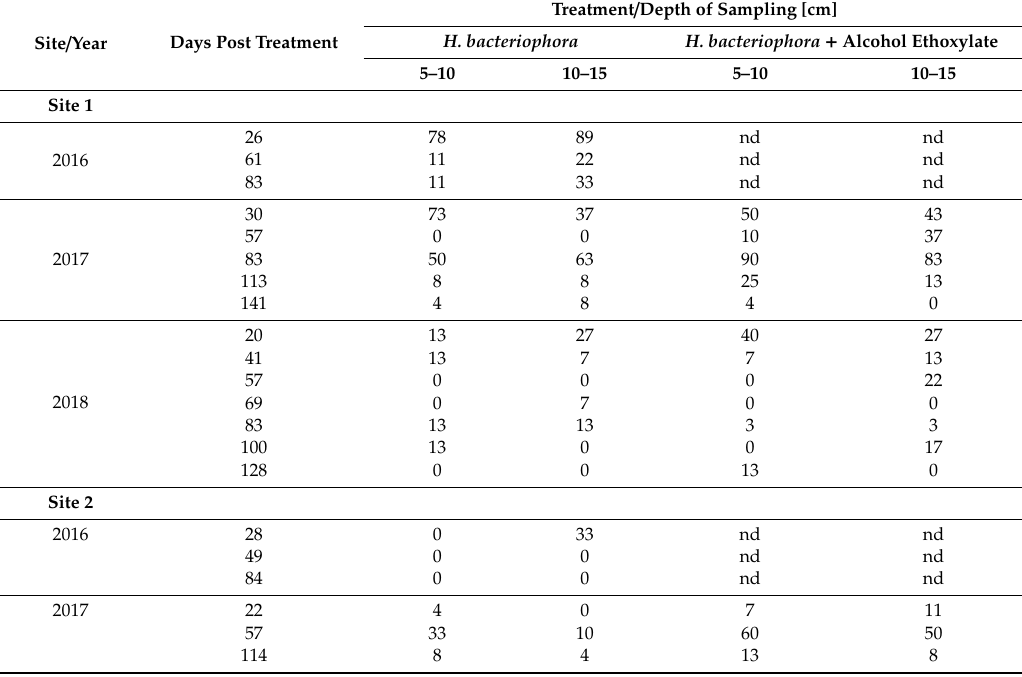
Table 5. Days of entomopathogenic nematode persistence at di ff erent depths (cm), expressed as the percentage of infected insect cadavers used as insect baits. Larvae of T. molitor and G. mellonella were used as live bait for entomopathogenic nematodes and placed on soil samples collected at two depths at both experimental sites; nd–no